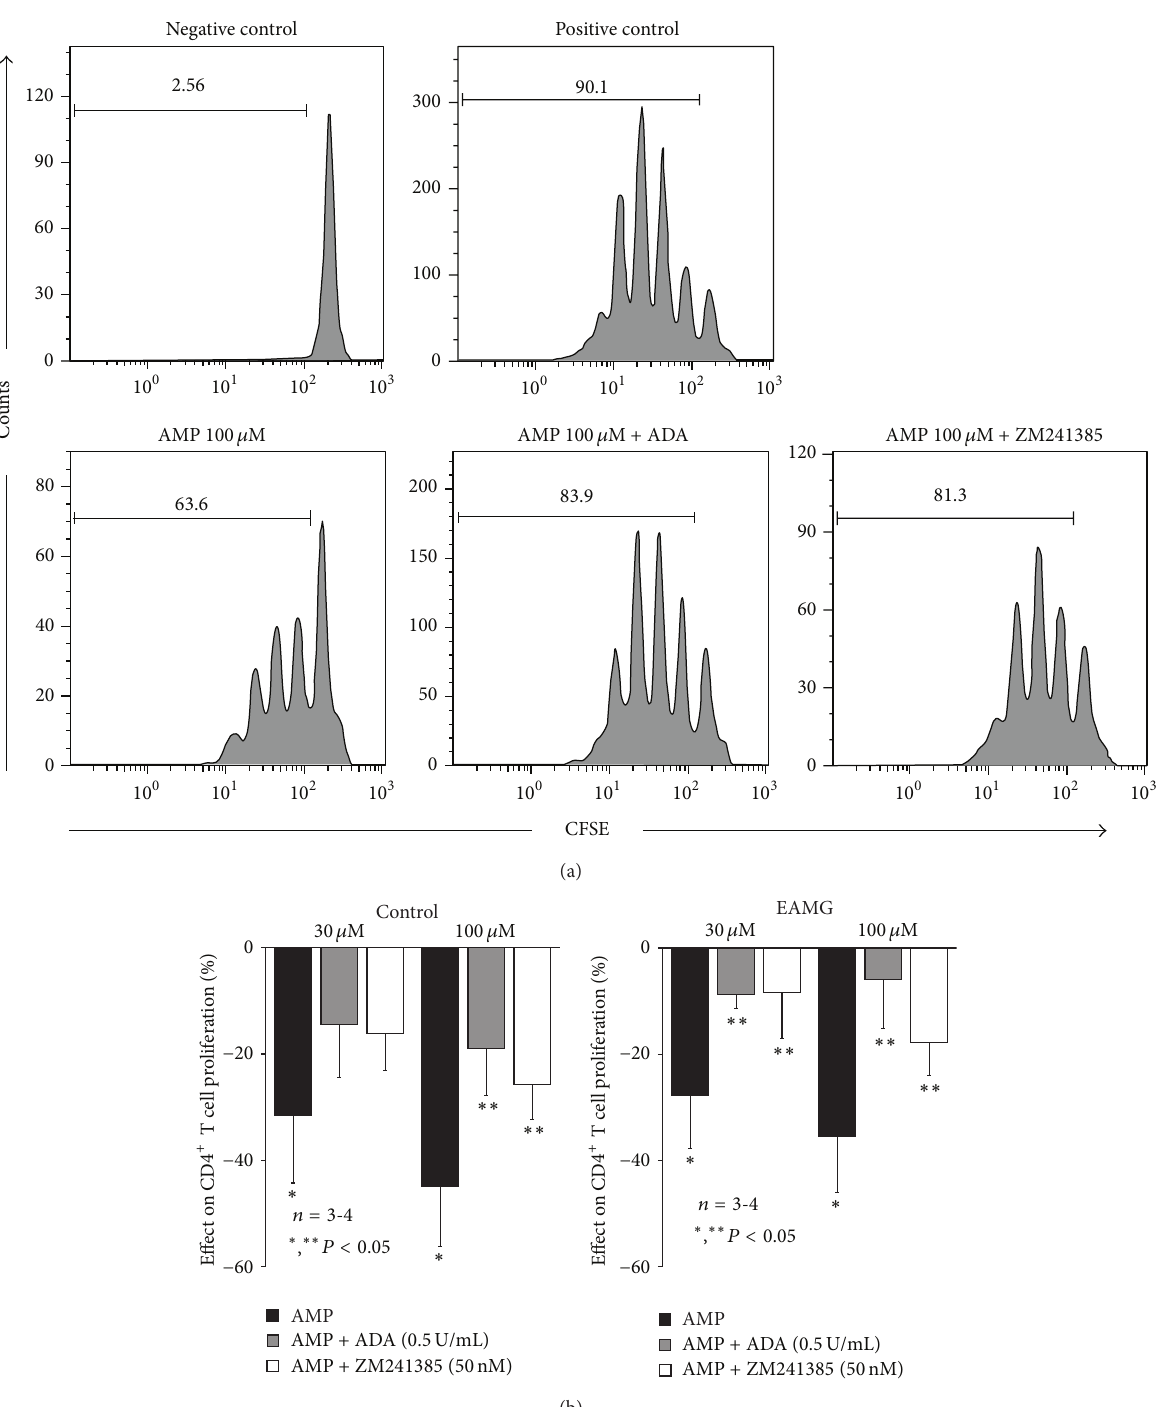
Figure 3: (a) Flow cytometric evaluation of plated anti-CD3 and soluble anti-CD28 mAbs (1 𝜇 g/mL) induced proliferative response of 5×10 4